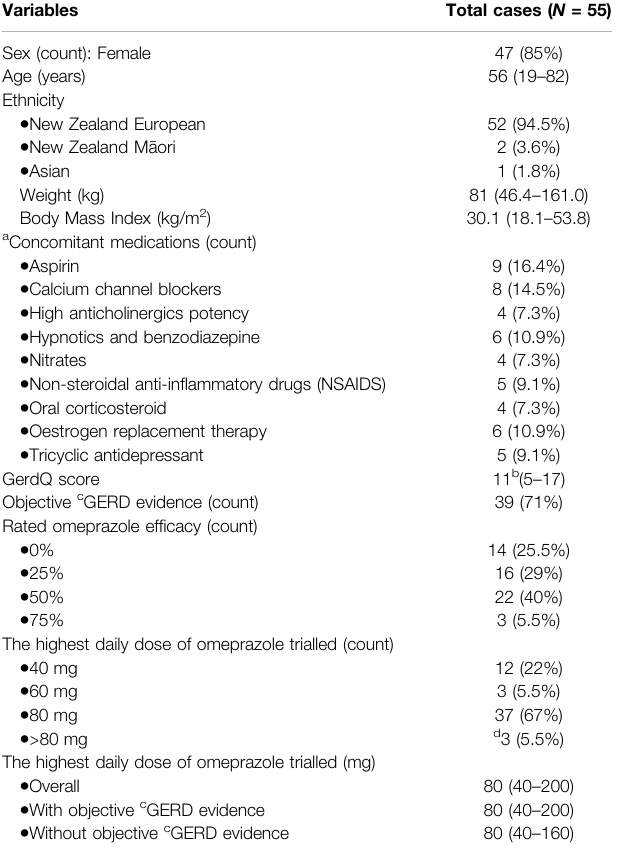
TABLE 1 | Summary of the recruited cases (median, range).